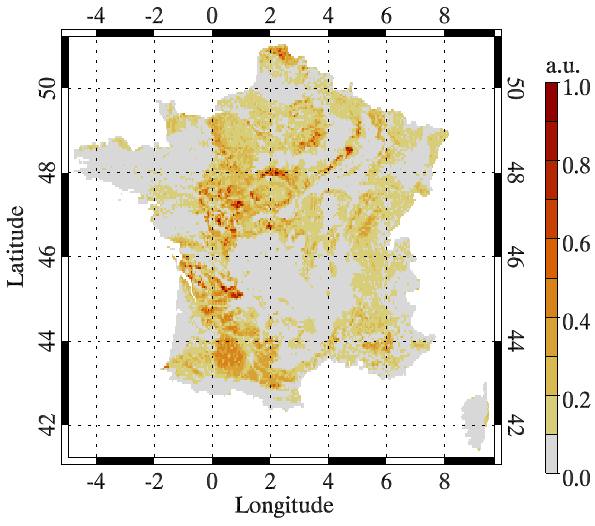
Fig. 1. Susceptibility to drought-induced soil subsidence from geology and land cover in arbitrary units (a.u.).